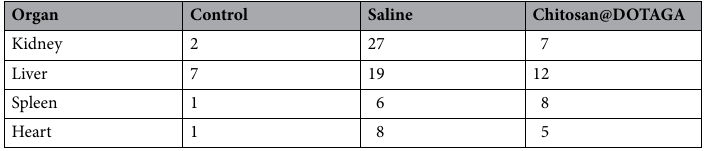
Table 3. Total histopathology scoring of mice organs after sacrifice. Total score was calculated as a sum of individual scores. At least 5 random fields of view were observed for each magnification (× 100, × 400) from which at least 3 were quantified. N = 7 control, N = 6 Saline & Chitosan@DOTAGA. Scoring and the assessed parameters for each organ detailed in the Supplementary Information, Table